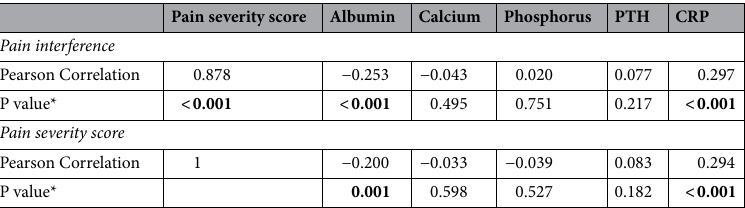
Table 4. Correlation between pain severity and pain interference with laboratory parameters (albumin, calcium, phosphorus, PTH, and CRP). CRP C-reactive protein; PTH parathyroid hormone. *The bold p value indicates that < 0.05, which considers